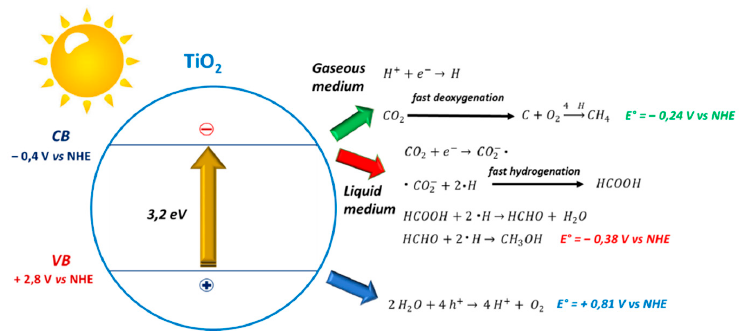
Figure 2. Different reaction mechanisms in the vapour and liquid phases. CB and VB energy levels have been taken from [109]. Table 2 . Summary of proposed mechanisms found in the literature.